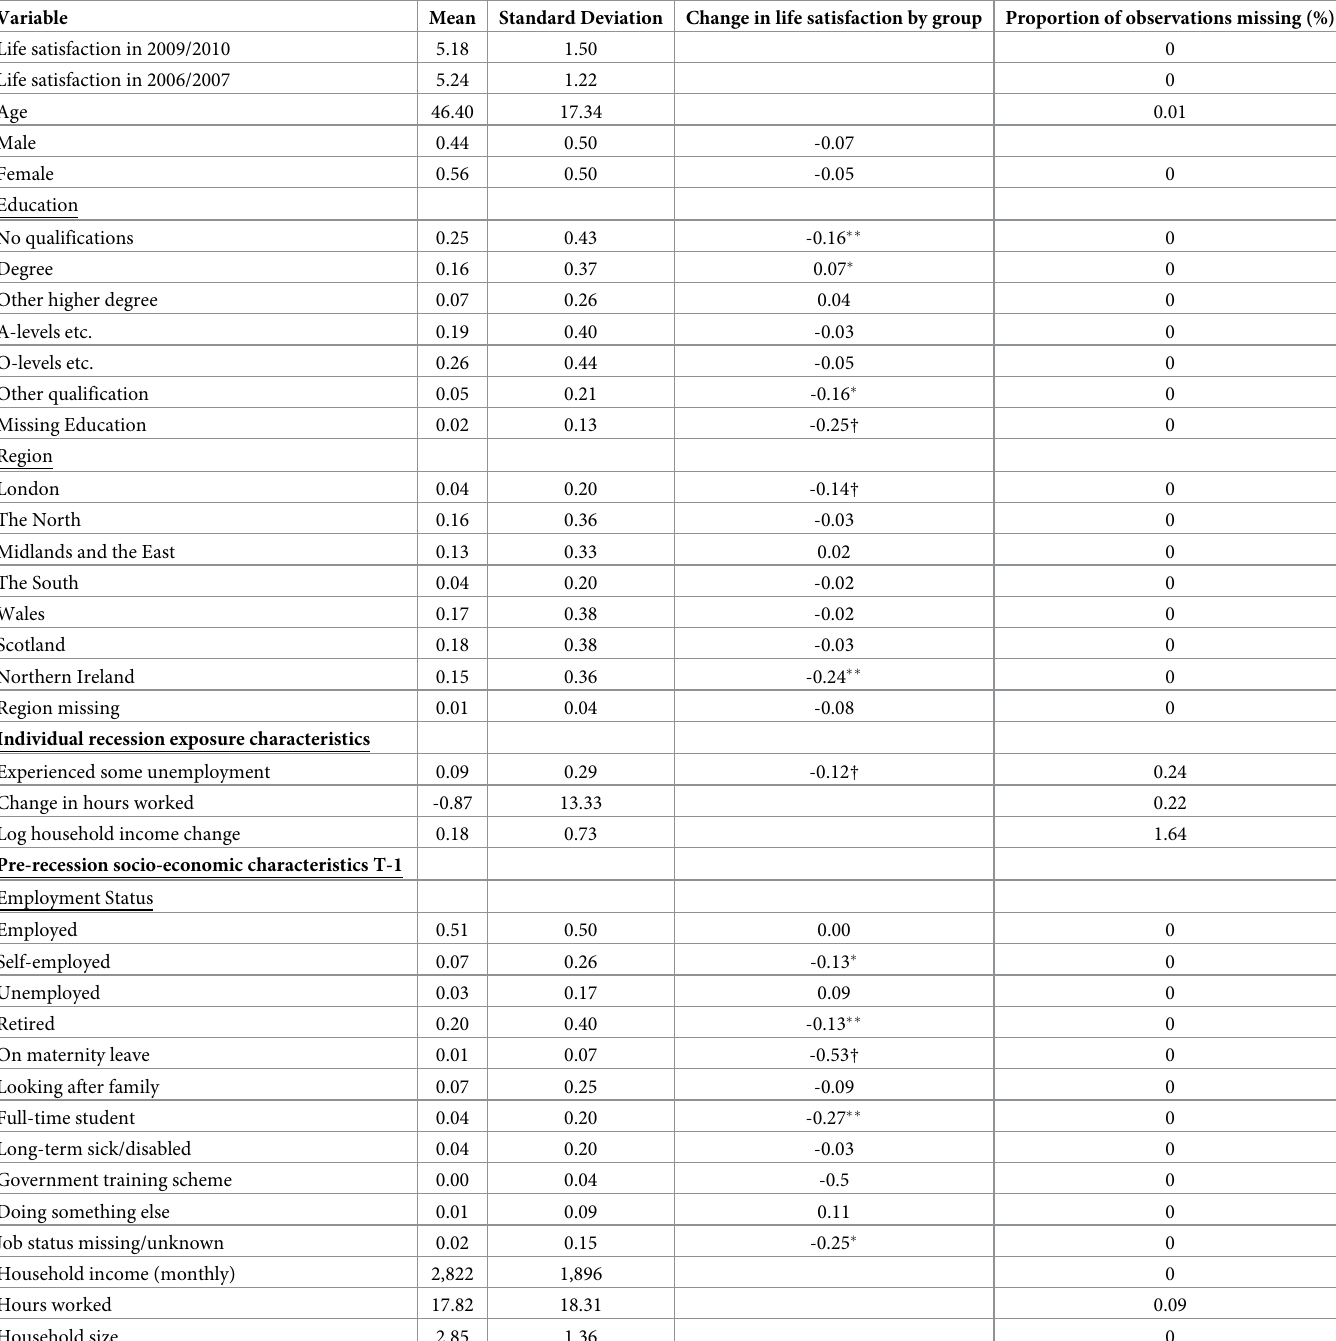
Table 1. Descriptive statistics and baselines changes in life satisfaction by group ( N = 8,661). Variable Mean Standard Deviation Change in life satisfaction by group Proportion of observations missing